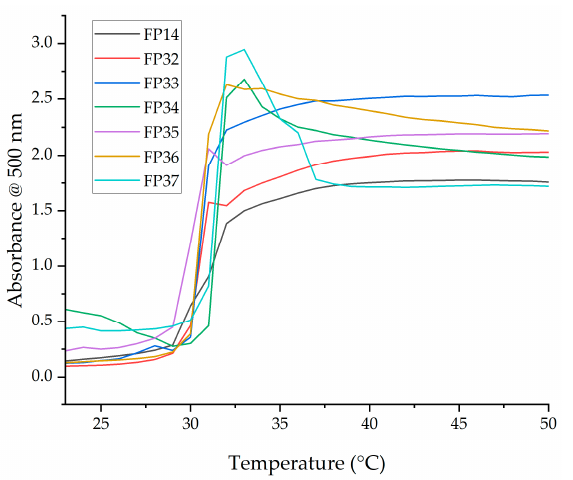
Figure 4. UV spectroscopy of the aqueous solutions of FP14, FP32, FP33, FP34, FP35, FP36, and FP37.